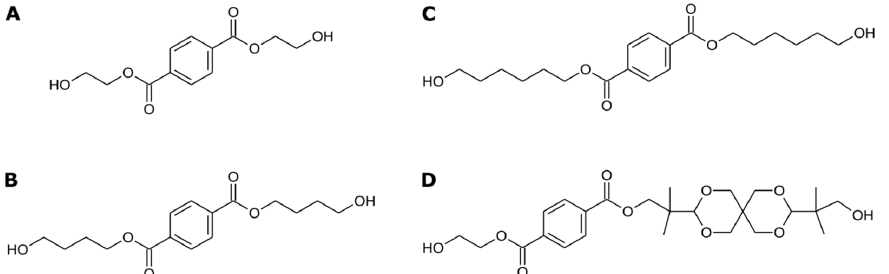
Figure 1. Modeled ligands. ( A ) Bis-(hydroxyethyl) terephthalate (BHET). ( B ) Bis-(hydroxybuthyl) terephthalate (BHBT). ( C ) Bis-(hydroxyhexyl) terephthalate (BHHT). ( D ) Akestra TM fragment.